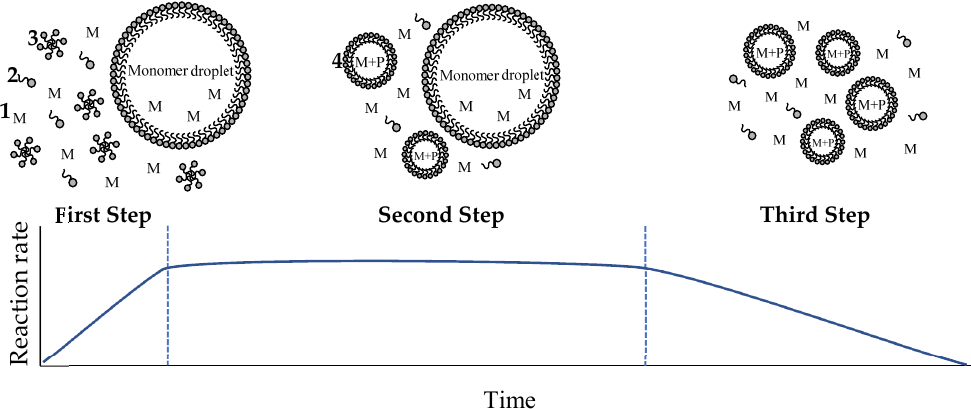
Figure 1. Schematic representation of the emulsion polymerization process and variation of reaction rate: ( 1 ) Monomer in aqueous phase; ( 2 ) free emulsifier; ( 3 ) micelles; and ( 4 ) polymeric particles.